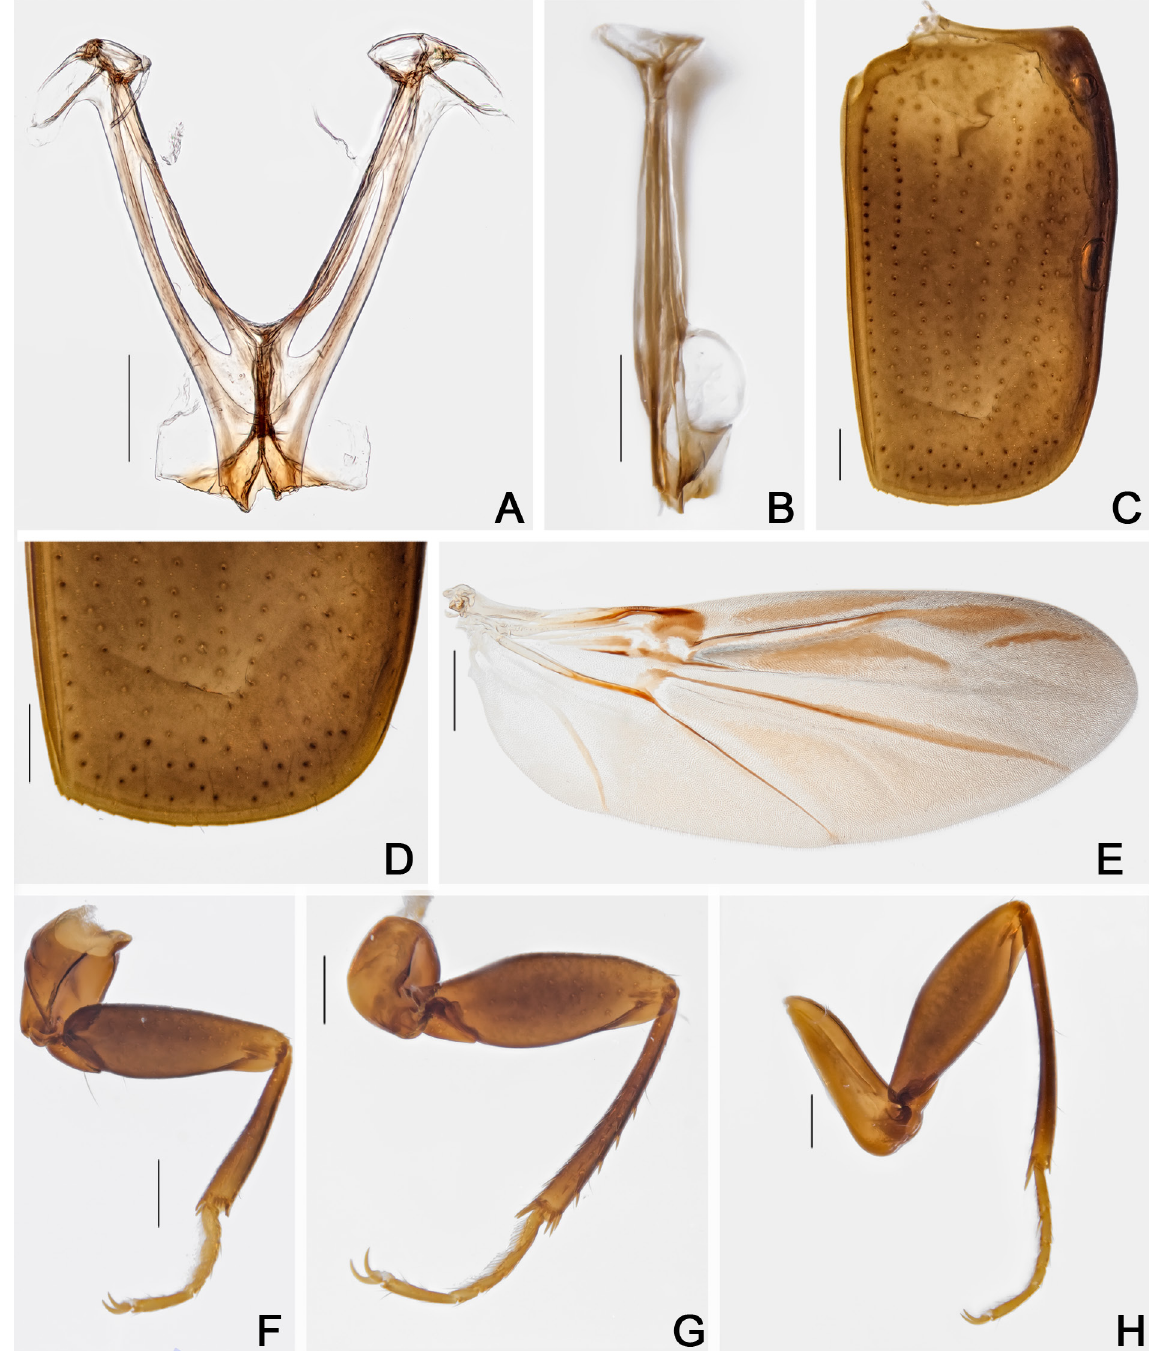
Fig. 26. Cyparium loebli sp. nov., paratype, ♂ (CELC). A–B . Metendosternite. A . Dorsal view. B . Lateral view. C–D . Elytron. C . Entire. D . Apex. E . Hind wing. F–H . Legs. F . Fore. G . Middle. H . Hind. Specimen collected at Mata do Paraíso, Viçosa (MG, Brazil). Scale bars: A–D, F–H = 0.2 mm; E = 0.5